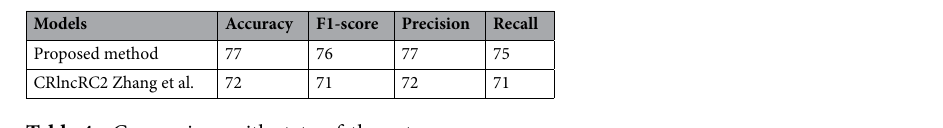
Table 4. Comparison with